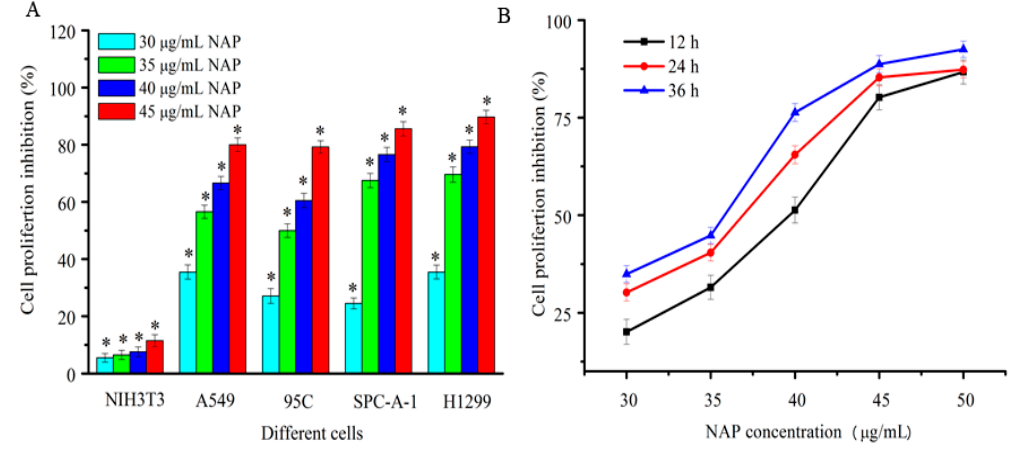
Figure 2. Inhibition of proliferation human lung cancer cells treated with NAP. ( A ) Proliferation inhibition of four human lung cancer cells treated by different NAP concentrations for 24 h; ( B ) Proliferation inhibition of H1299 cell lines treated with different NAP concentrations for 12, 24 and 36 h. * p < 0.05 vs. control.